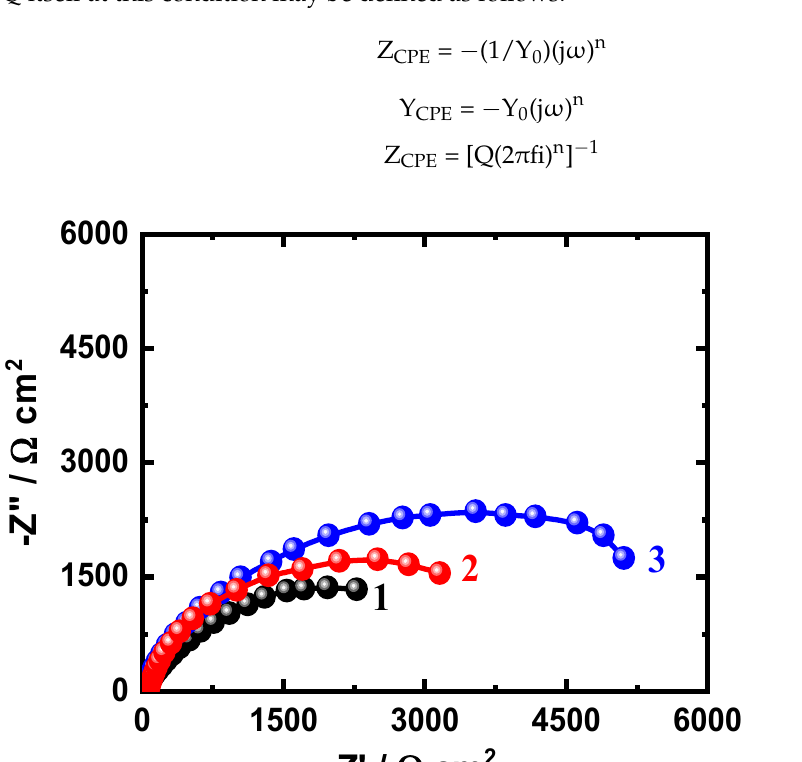
Figure 6. Nyquist plots obtained for (1) first Al-SiC nanocomposite, (2) second Al-SiC nanocomposite and (3) third Al-SiC nanocomposite after their immersion in 3.5% NaCl solutions for 1 h.